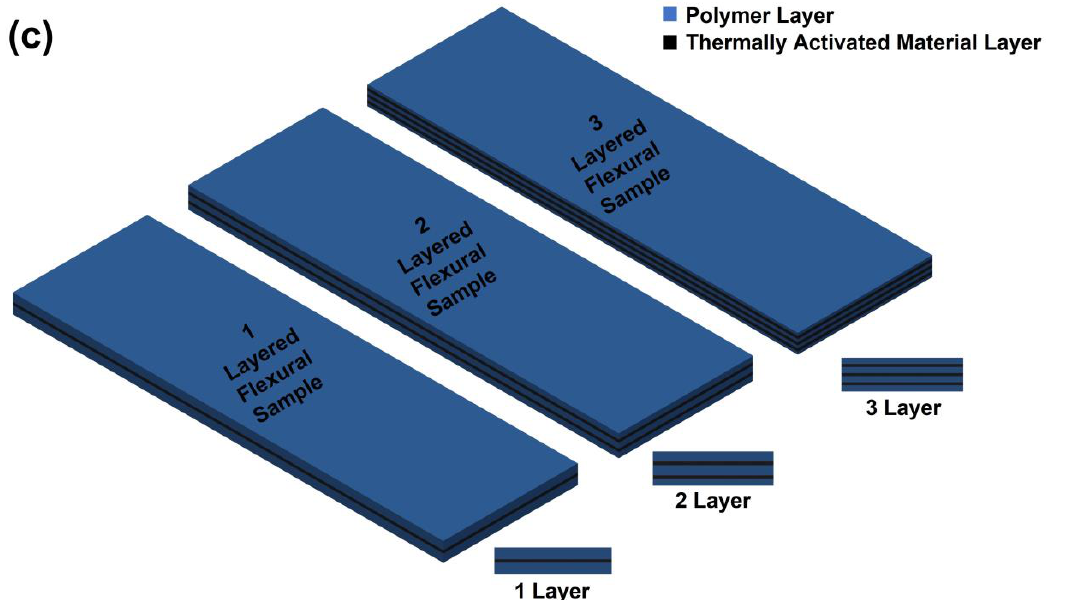
Figure 3. Schematics of ABS/TA materials layout: ( a ) tensile test samples; ( b ) hardness test samples; ( c ) three-point flexural test samples.